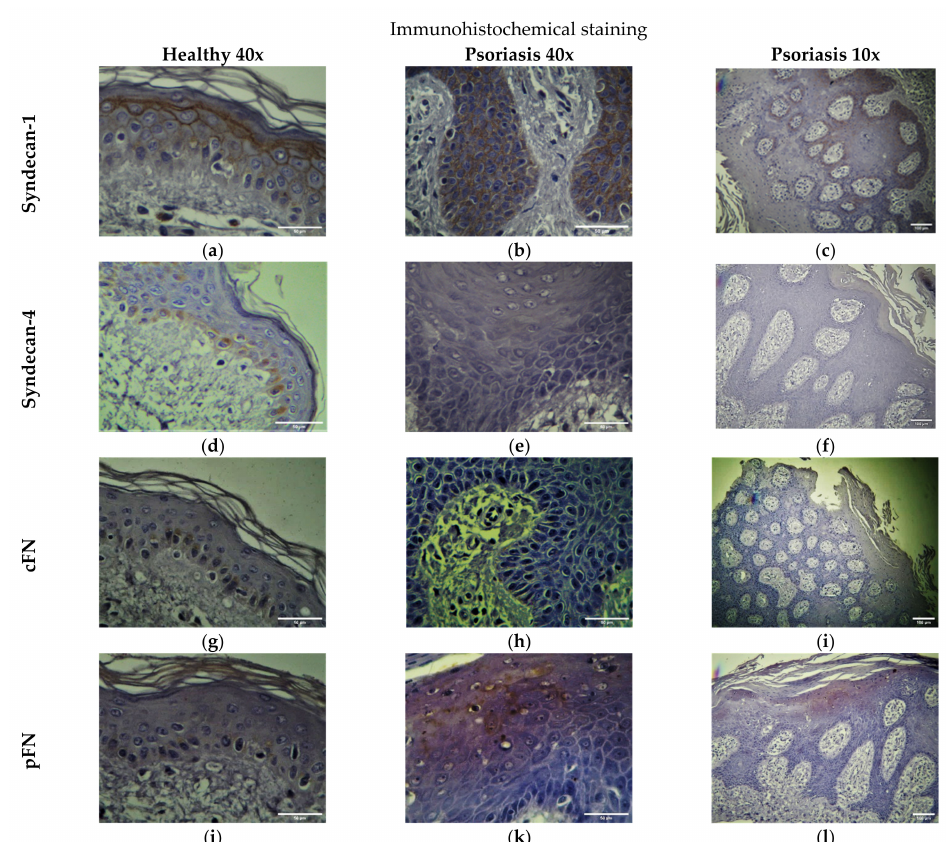
Figure 1. Immunohistochemical analysis of skin biopsies from lesional skin of patients with psoriasis. ( a ) Syndecan-1 expression in non-psoriatic, healthy epidermis. ( b , c ). Syndecan-1 expression was rather strong in the psoriatic epidermis at magnifications 10x and 40x. ( d ) Syndecan-4 in non-psoriatic epidermis. ( e , f ). Expression of syndecan-4 in psoriatic epidermis at magnifications 10X and 40x. ( g ) Cellular FN-EDA domain staining in non-psoriatic skin. ( h , i ). Patches of staining observed below the basal epidermal layer of psoriatic skin likely corresponding to the basement membrane zone at two magnifications. ( j ) Plasma fibronectin staining in the basal layer of non-psoriatic skin. ( k , l ). Plasma fibronectin staining in the psoriatic